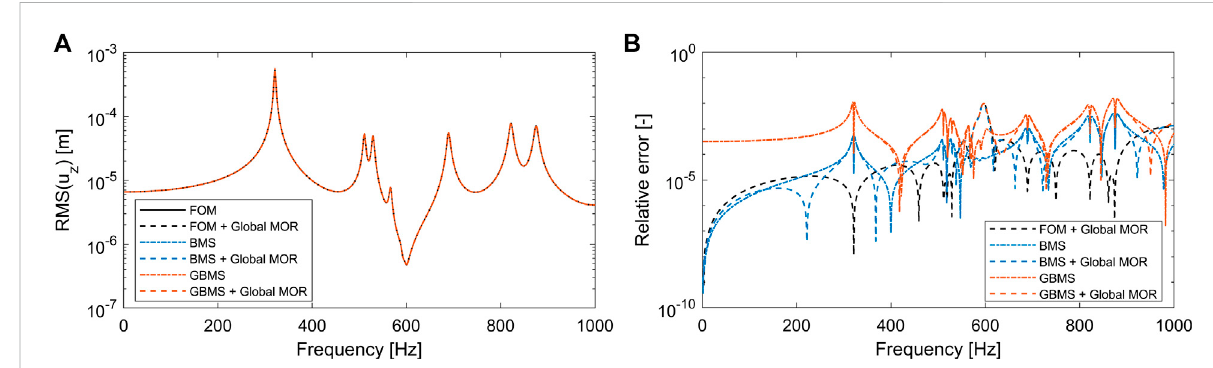
FIGURE 4 Forcedvibration frequencyresponses (A) andrelativeerrorthereofwithrespecttotheFOM (B) computedfortheclamped fi niteplateassembly of 5 × 5 UCs for different ROMs. The good agreement between the results causes the frequency responses (A) to appear on top of each other.